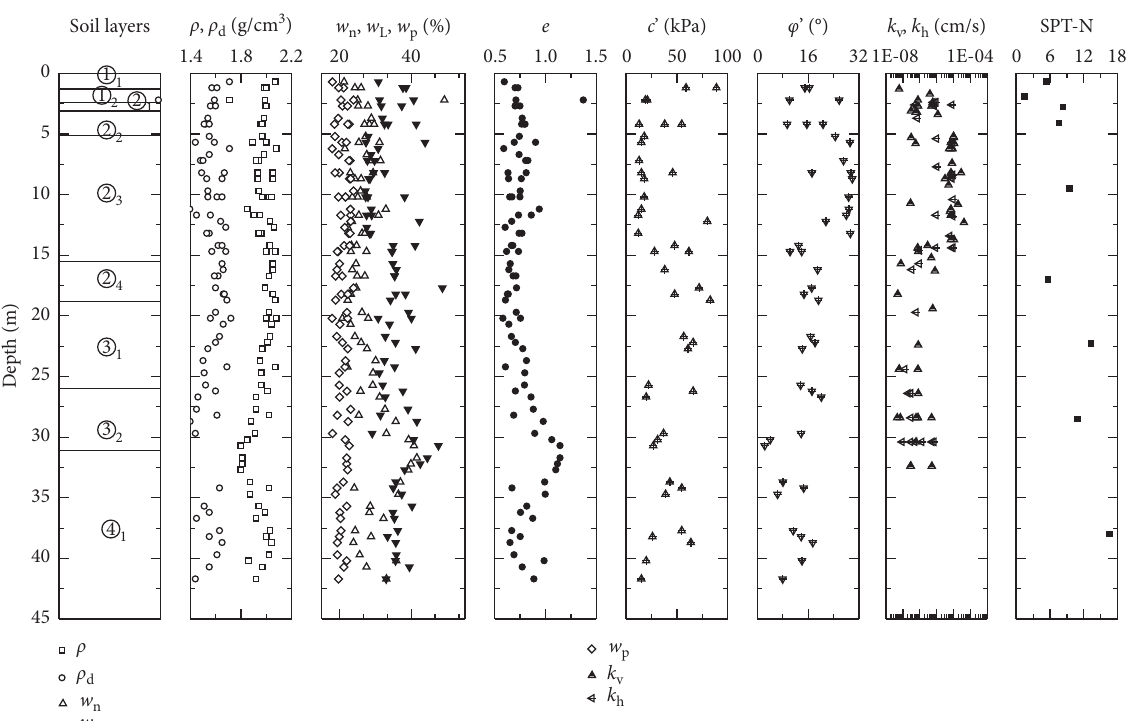
Figure 3: Geotechnical parameters of soft